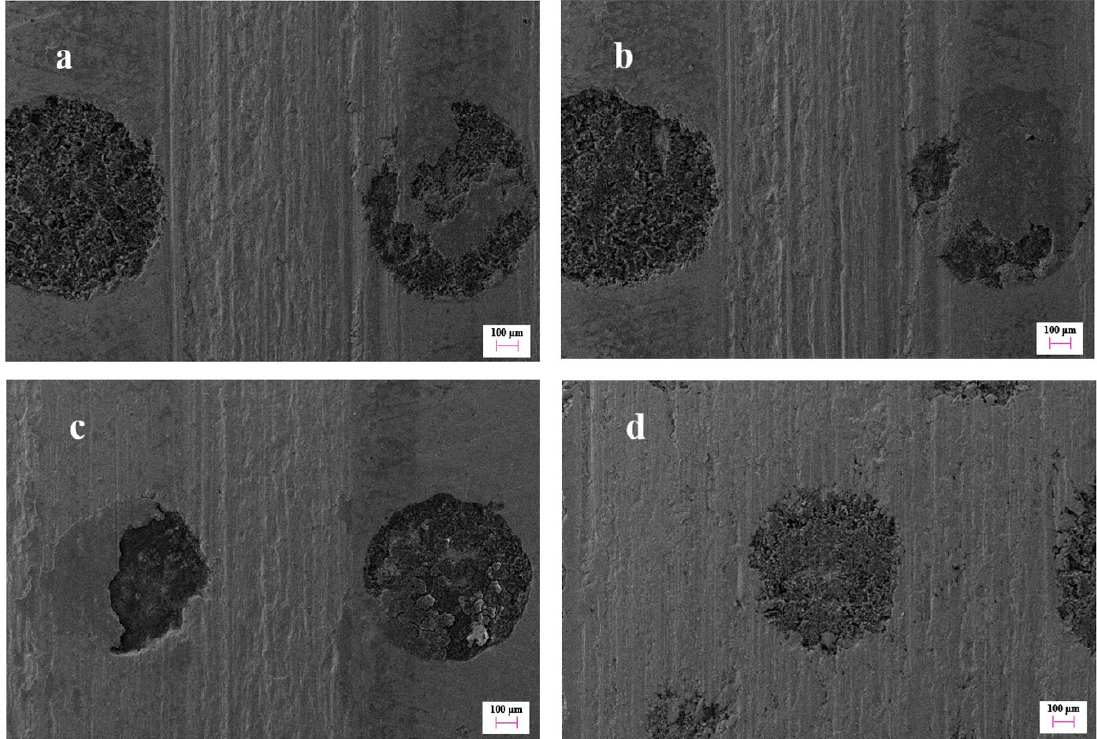
Figure 14. The topography variation of micro-dimpled cylinder liner at point B ( a ), point C ( b ), point D ( c ), and point E ( d ) in Figure 6 during the